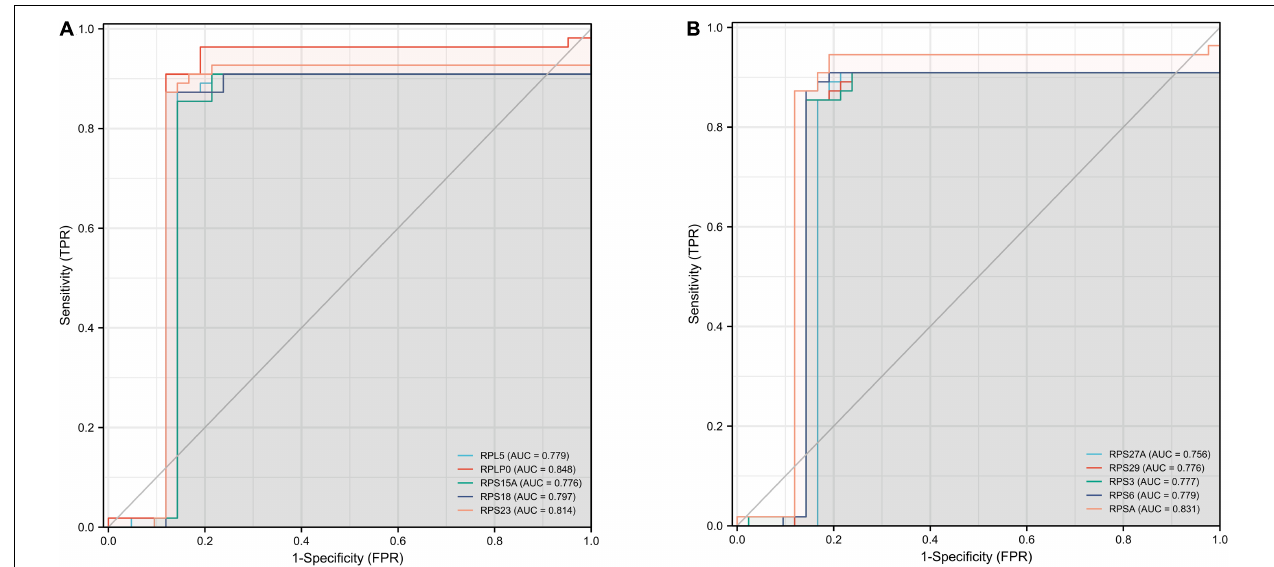
FIGURE 7 | ROC curves for the top ten hub genes. The abscissa represents the FPR and the ordinate represents the TPR. The value of the AUC represents the accuracy of the diagnostic value, with values closer to 1 indicating better accuracy. ROC, operating receiver characteristic; FPR, false positive rate; TPR, true positive rate; AUC, area under the curve. (A) RPL5, RPLP0, RPS15A, RPS18, and RPS23. (B) RPS27A, RPS29, RPS3, RPS6, and